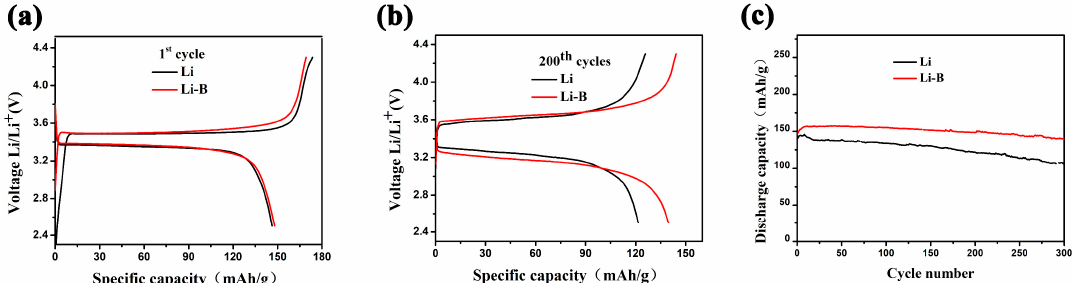
Figure 2. Charge and discharge profiles of Li/LiFePO 4 and LiB/LiFePO 4 battery of the 1st cycle ( a ) and 200th cycle ( b ); cycling performances of these two batteries ( c ).